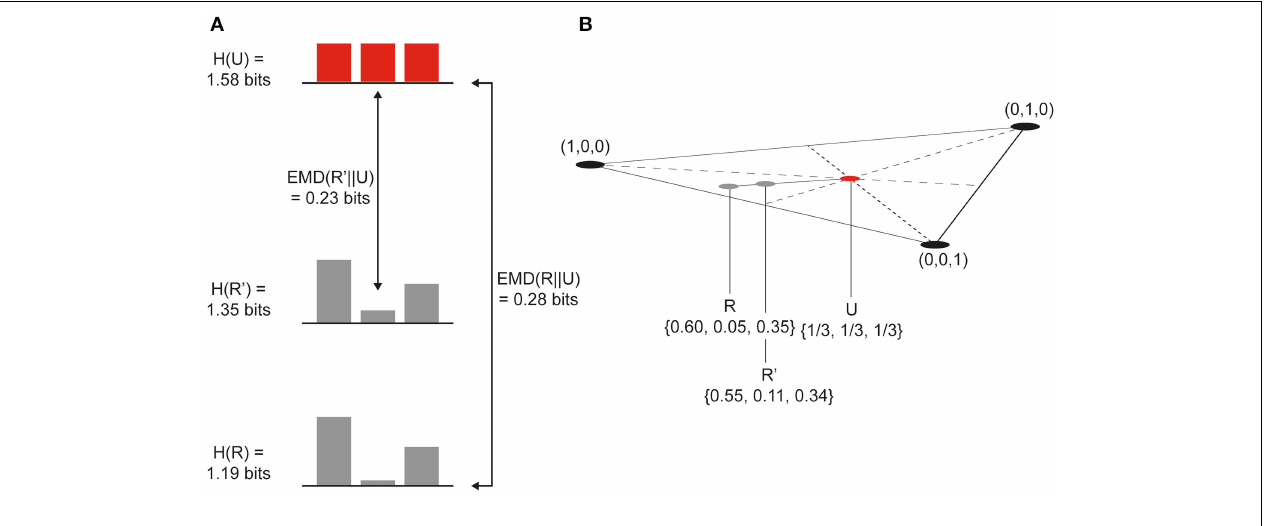
FIGURE 5 | (A) Simple 3-state system. A psychedelic (cause/effect) repertoire, R’, is generated using a linear combination of the (cause/effect) repertoire, R, and the unconstrained (past/future) repertoire, U. R’ has a higher entropy than R and is closer to U,